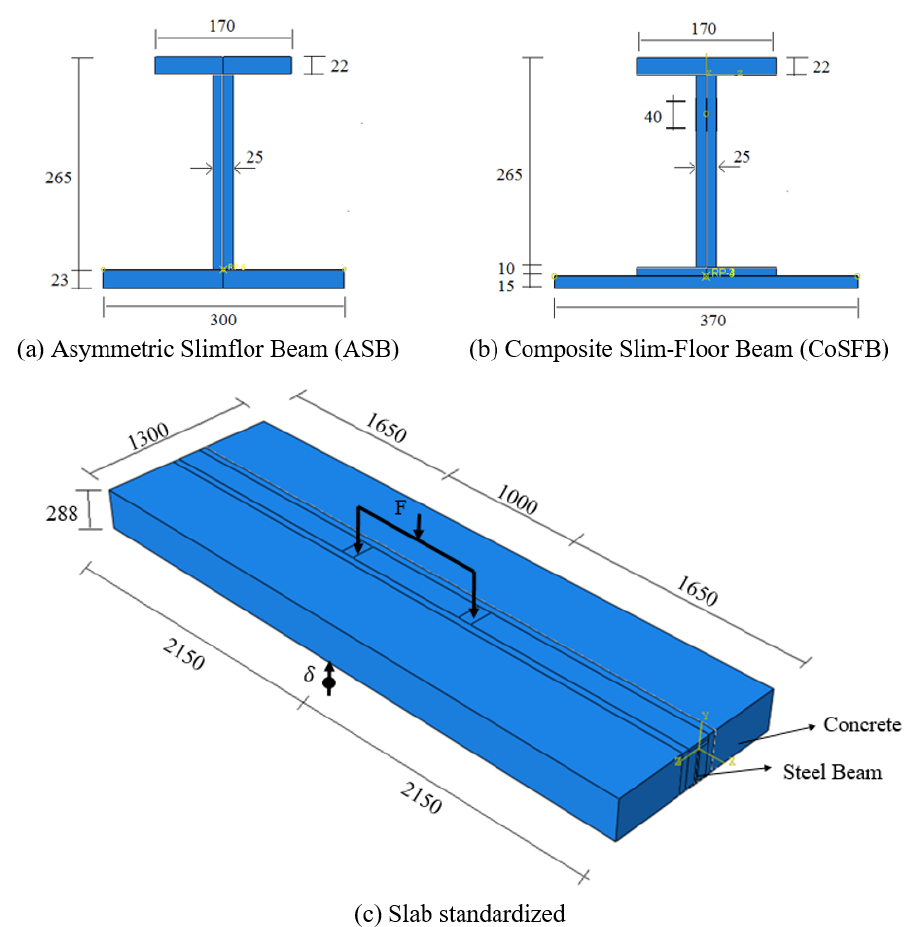
Figure 7. Geometric dimensions standardized (mm).